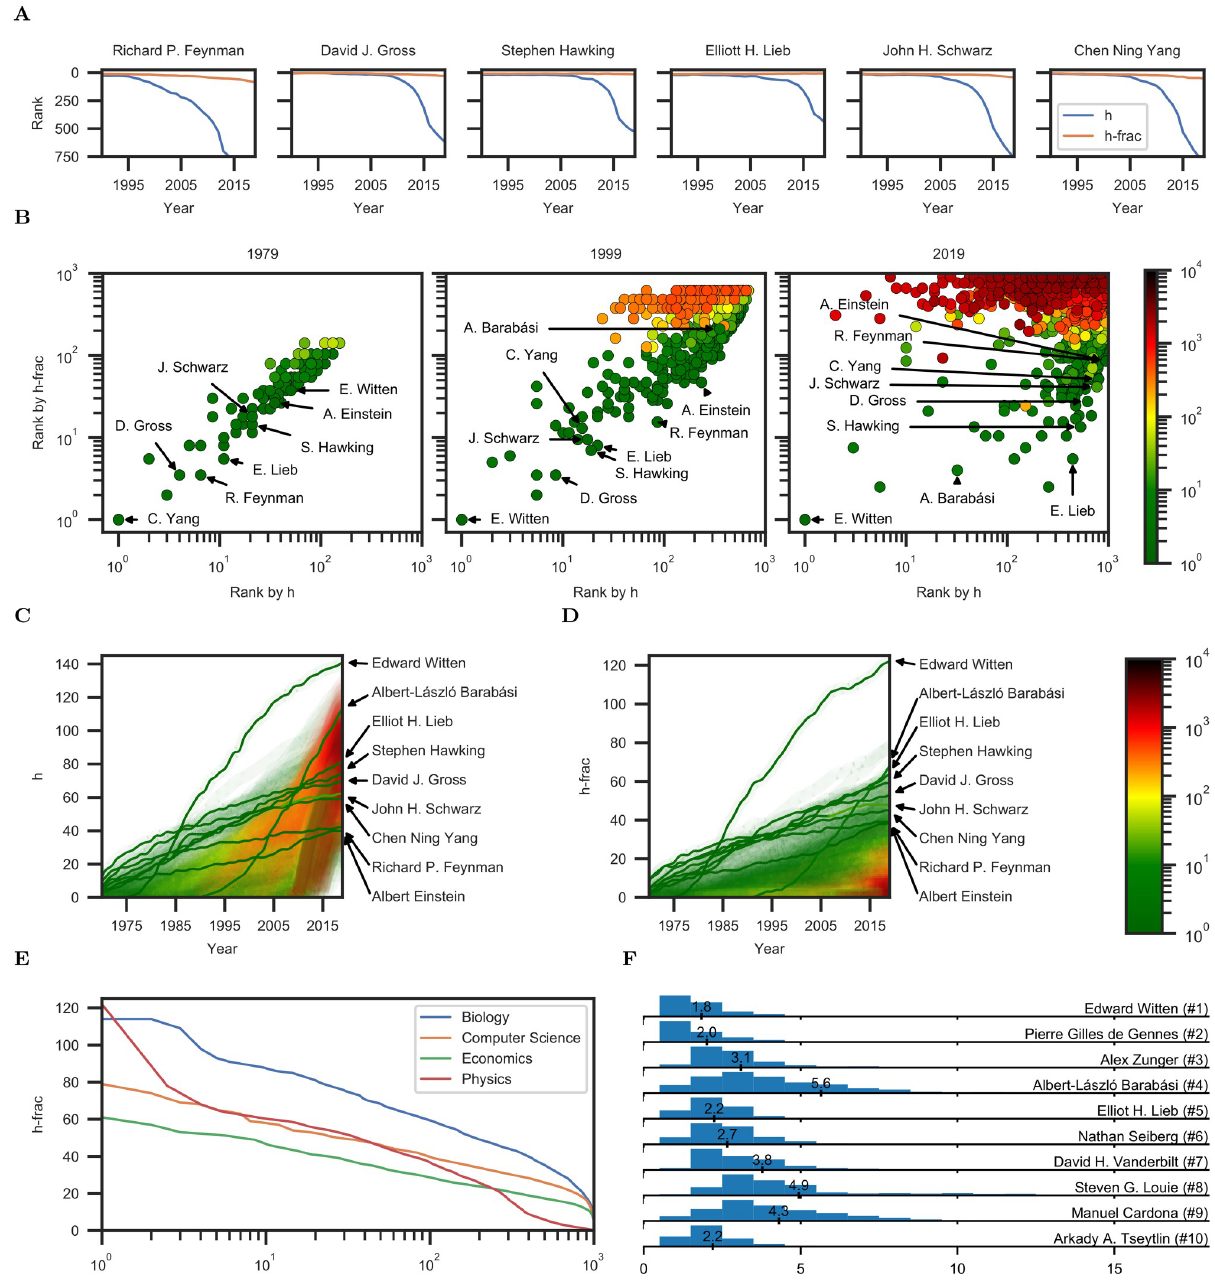
Fig 5. Further analysis. ( A ) Ranking induced by h and h-frac for a number of scientists in the Scopus physics dataset. ( B ) Comparison of rankings induced by h and h-frac in the Scopus physics dataset. Scientists are color-coded by the average number of coauthors per publication. ( C ) Evolution of the h-index of each scientist in the Scopus physics dataset over time. Each scientist is a curve. Color represents the average number of coauthors per publication. ( D ) Evolution of h-frac over time. ( E ) Distribution of h-frac values in each field of research. ( F ) Distribution of the number of authors per publication for 10 physicists with the highest h-frac in